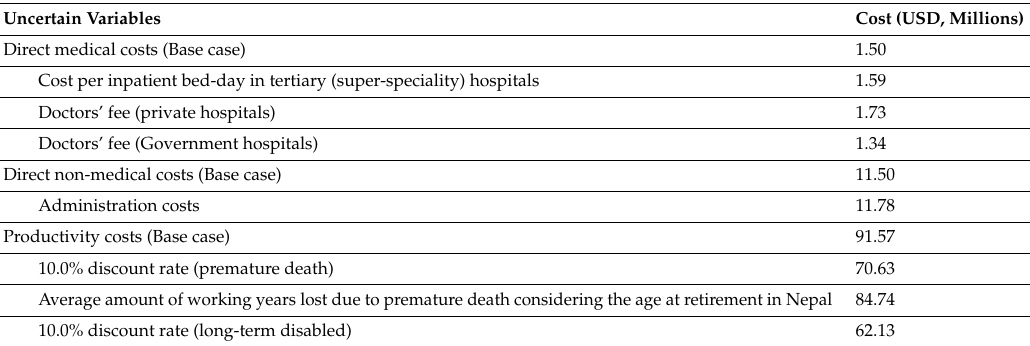
Table 5. Sensitivity